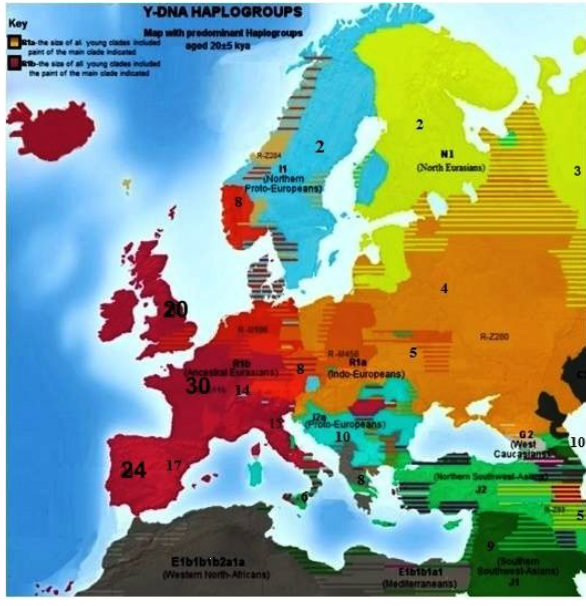
Figure 3. Haplogroups and distribution of deaths per million people into European territory